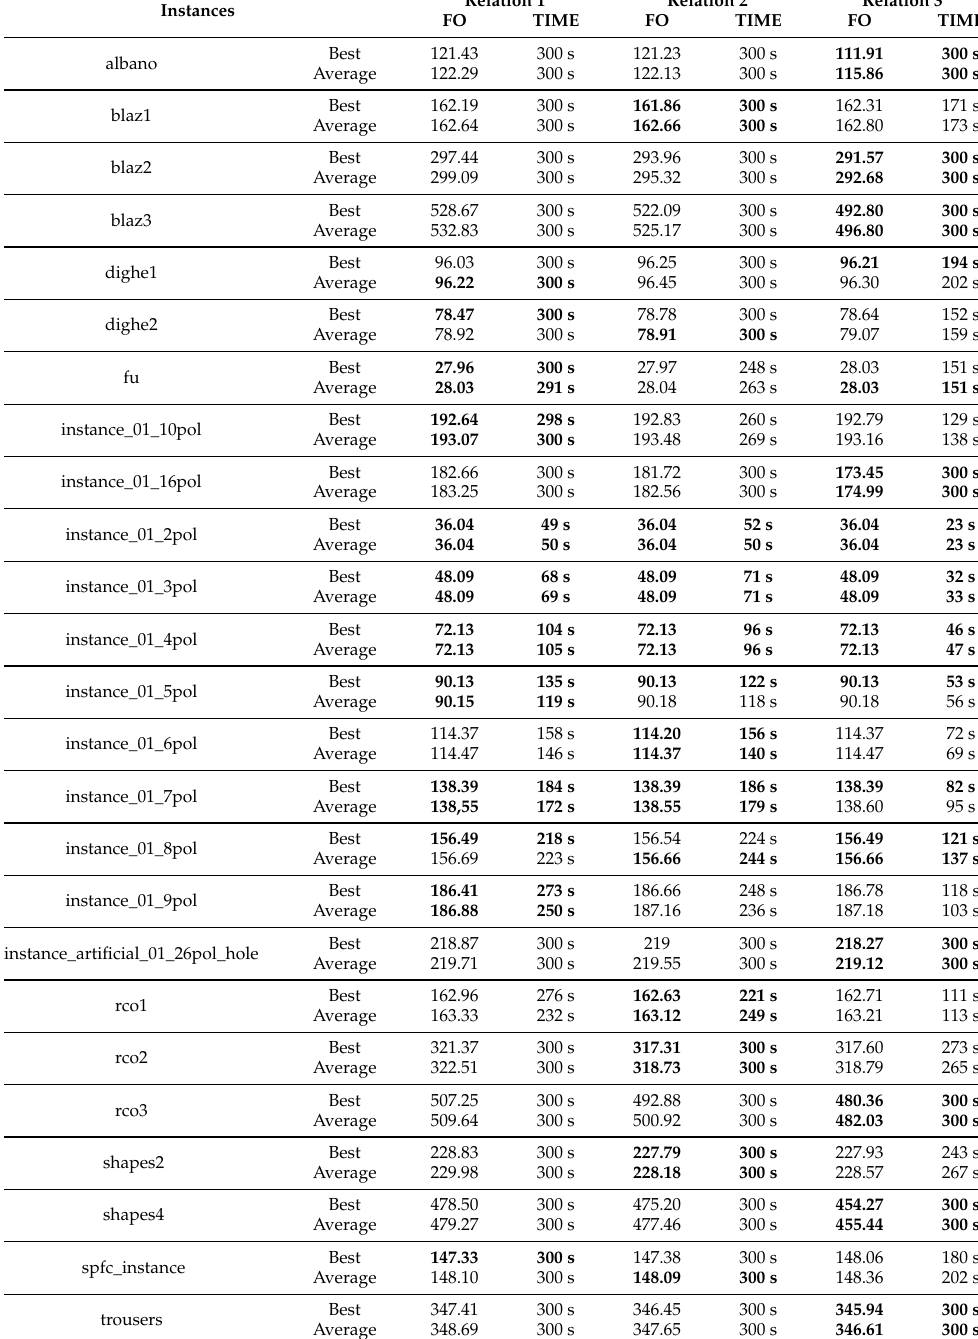
Table A4. Separated instances (S) for considered configurations. Relation 1: P = 10,000; Pe =